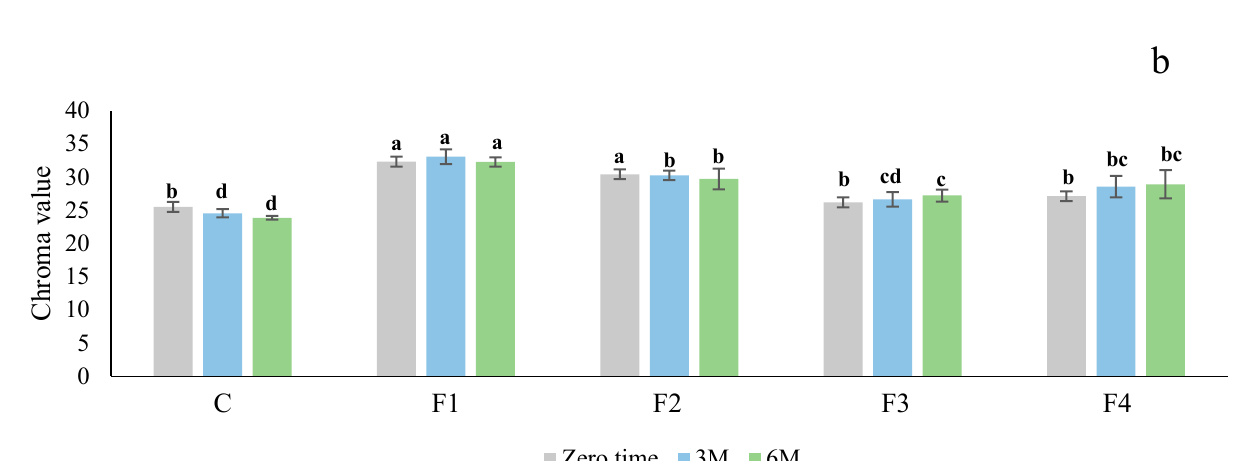
Figure 1. Effect of different edible coatings on the skin color of Ciklamen ( a ) and Modoc ( b ) after six months of cold storage at 4 ± 2 °C and 90 ± 5% RH. Data are expressed as mean ± SD, n = 15. The different letters on the bars are indicative of statistical significance ( p < 0.05). C: control. F1: sodium alginate. F2: potato starch + sodium alginate emulsion with oregano